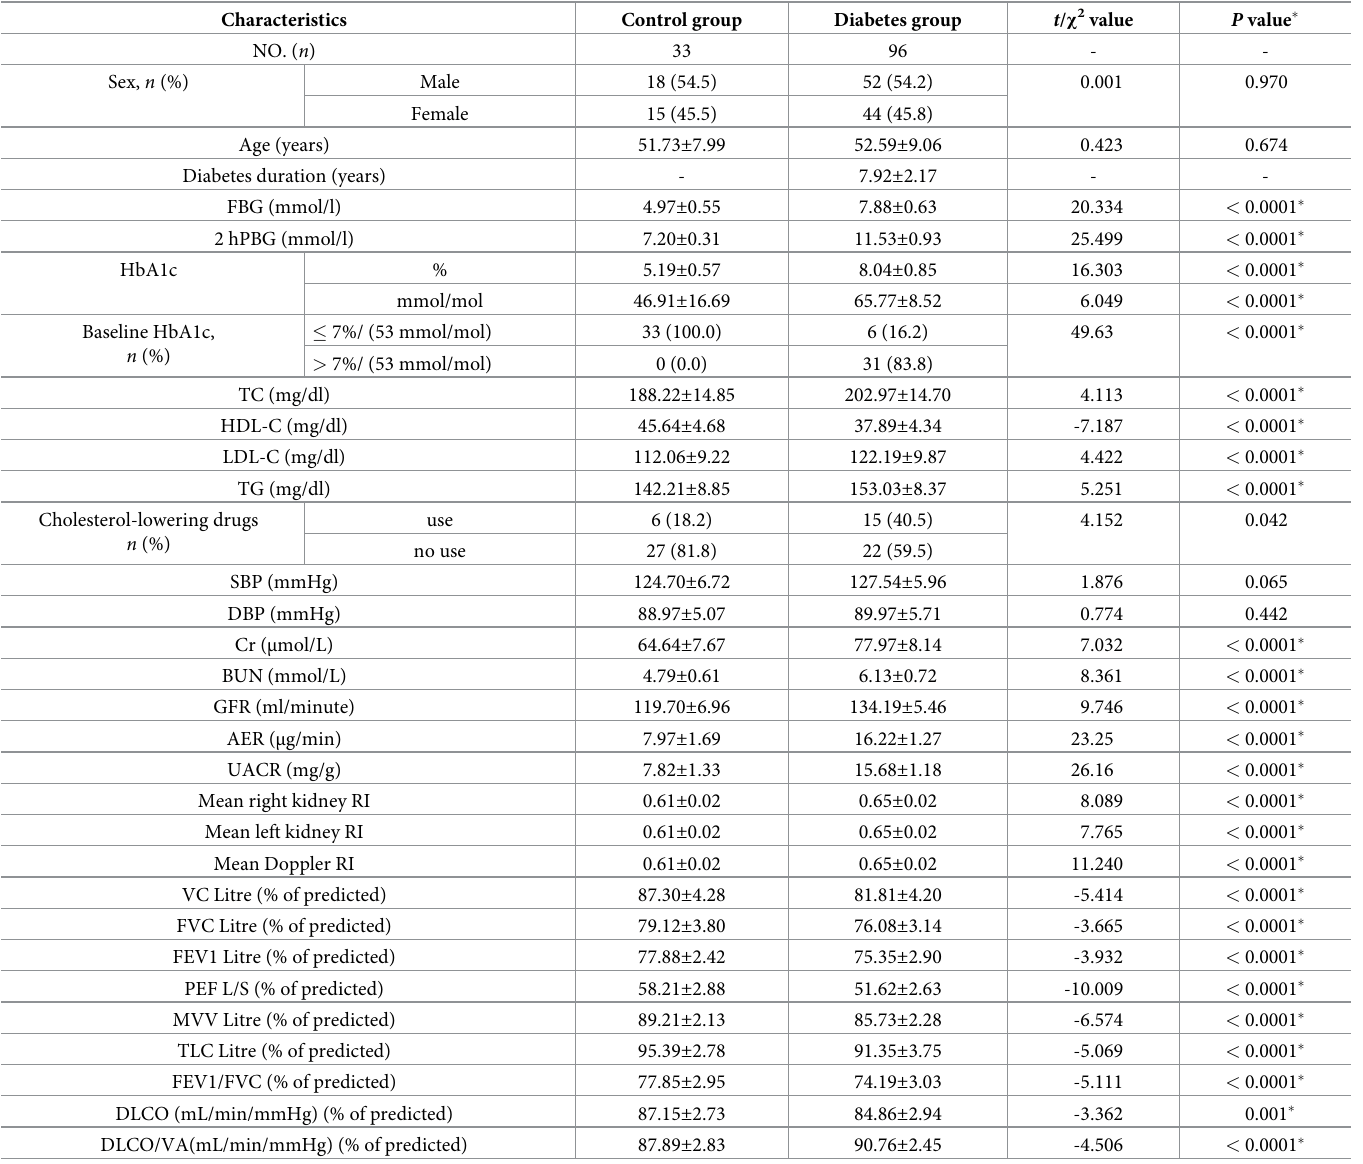
Table 1. Baseline demographic and clinical characteristics.